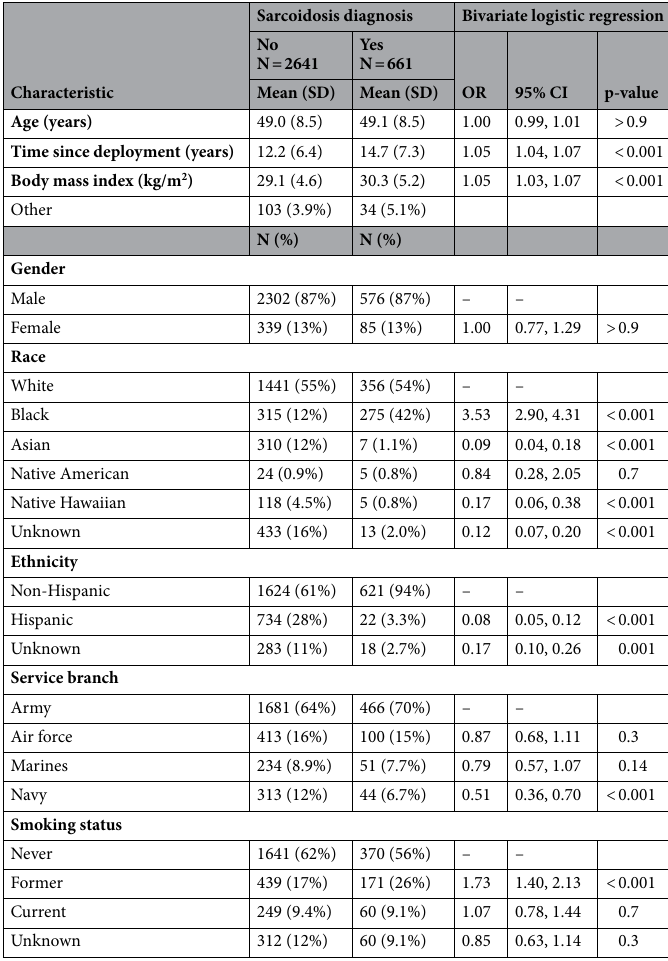
Table 1. Characteristics of airborne hazards and open burn pit registry participants with sarcoidosis documented by international classification of disease (ICD) code in Veterans Health Administration